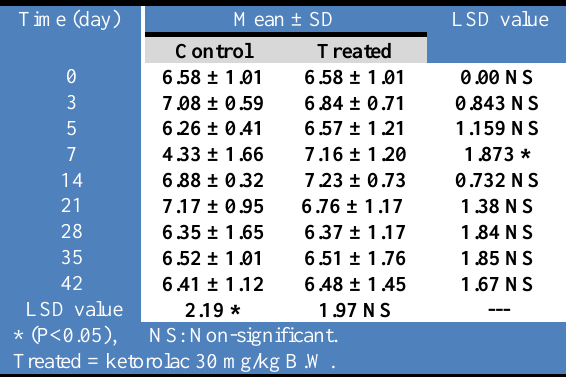
Table, 1: Shows Red Blood cells count (×10*12/L) in control and treated